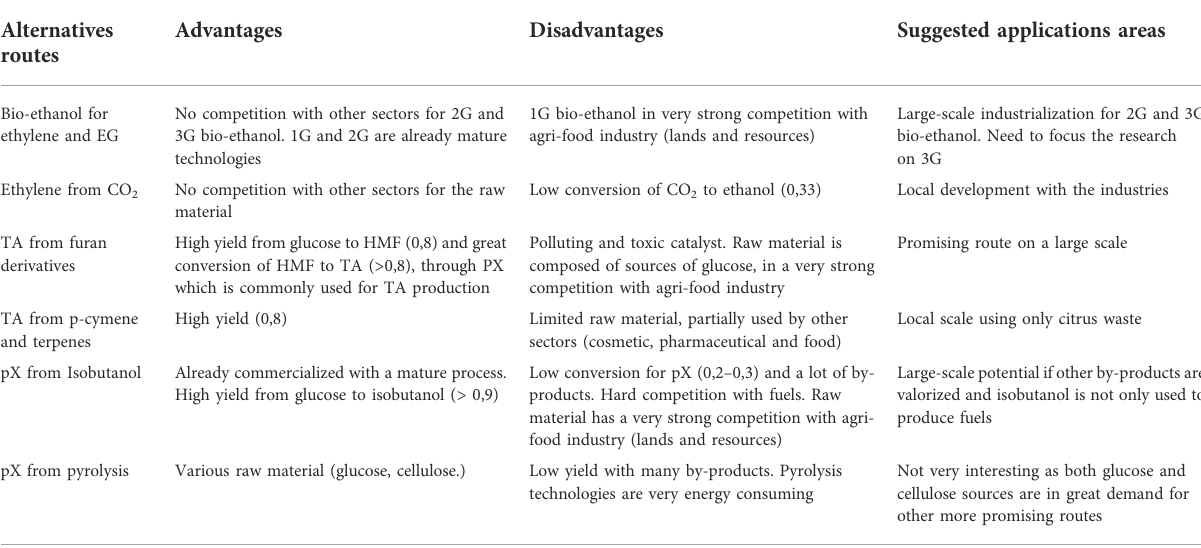
TABLE 6 Authors points of view on the alternative routes